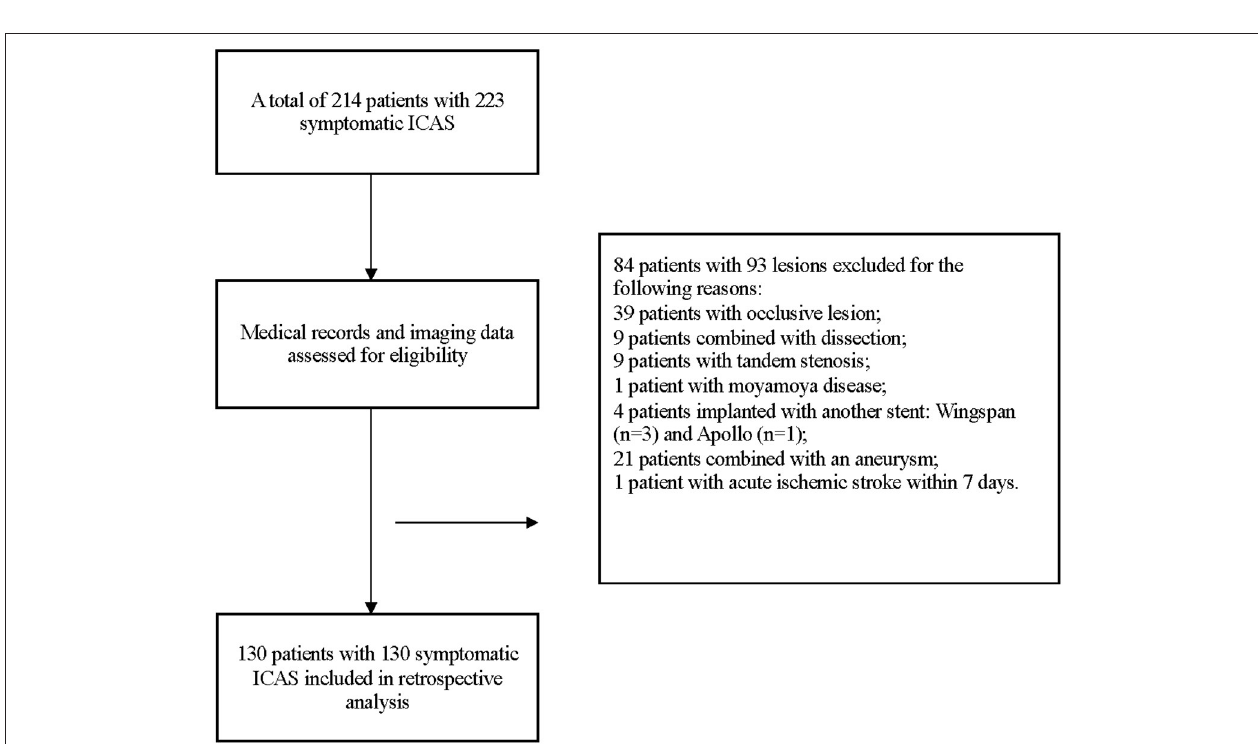
FIGURE 3 | Selection of patients or lesions for analysis in the